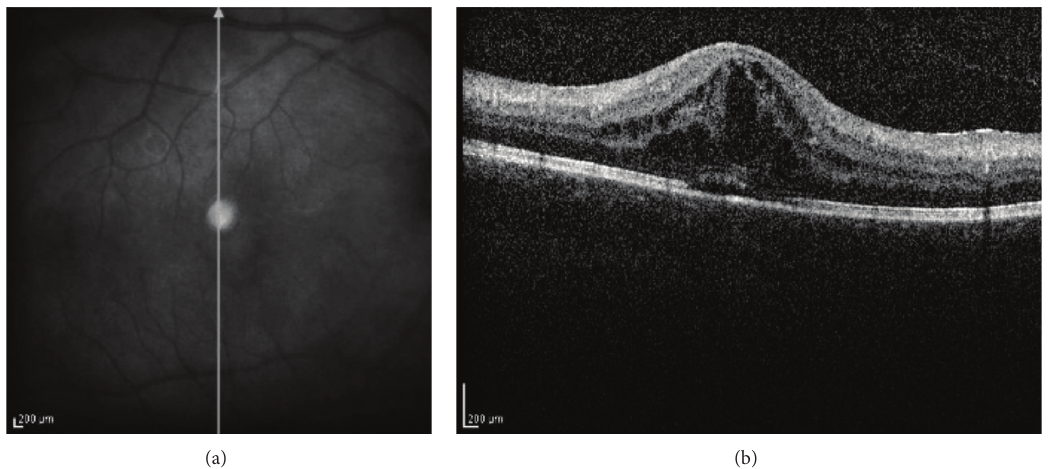
Figure 3: Patient no. 4: right eye. Scanning laser ophthalmoscope fundus image (on the left) showing the position of optical coherence tomography (OCT) section. Spectralis OCT (on the right) shows severe macular edema and a foveal detachment (foveal thickness 600 𝜇 m).